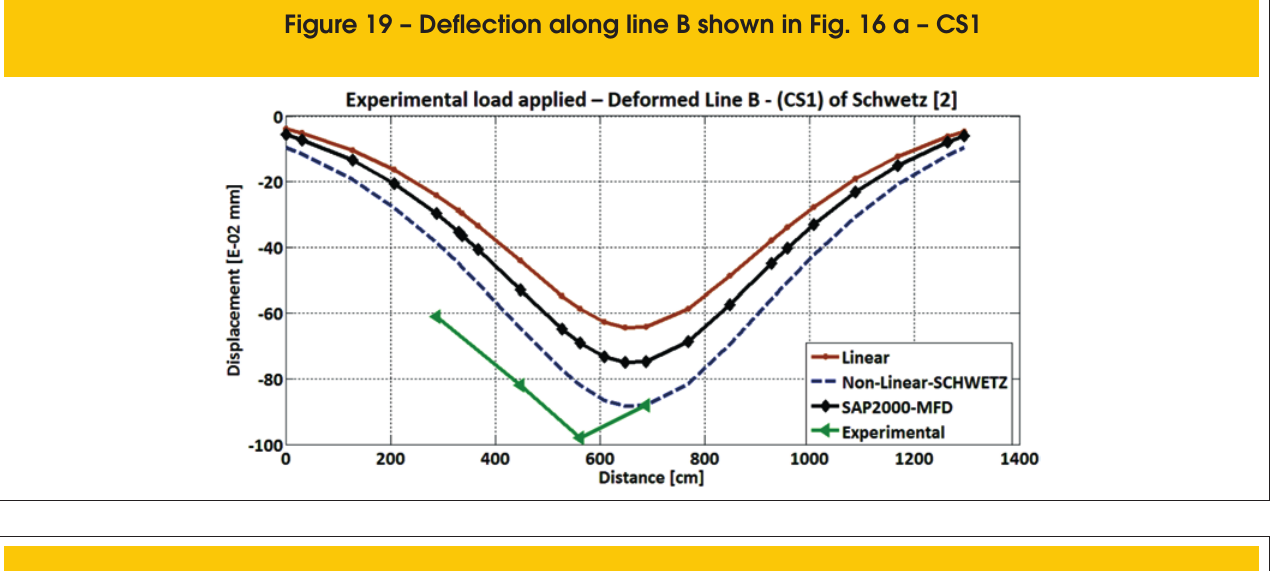
Figure 19 – Deflection along line B shown in Fig. 16 a – CS1